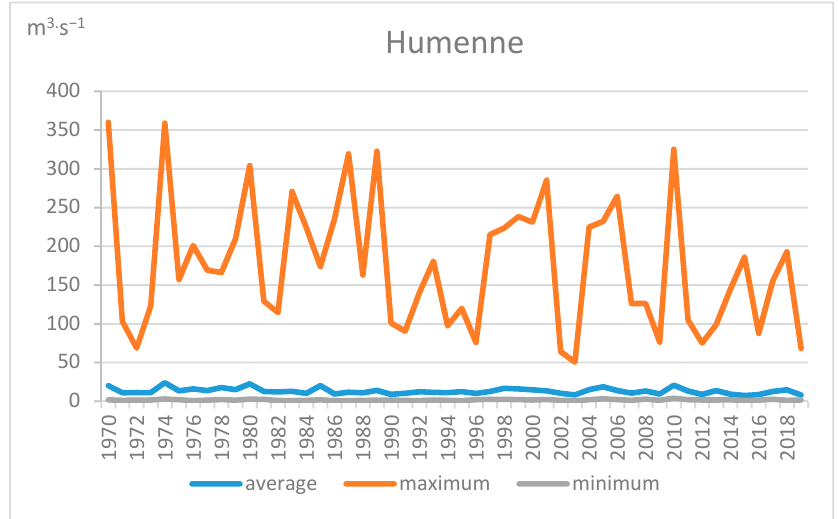
Figure 3. Average, maximum, and minimum flows of the Laborec River at Humenne gauging station in the hydrological years 1970–2019.